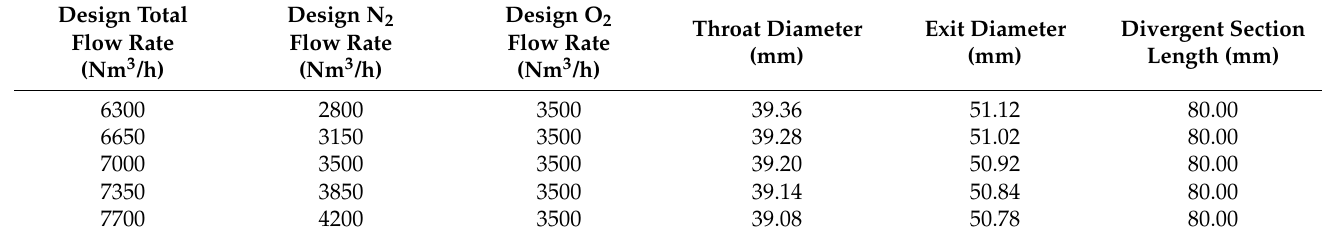
Table 1. The parameters of various Laval nozzle structures.